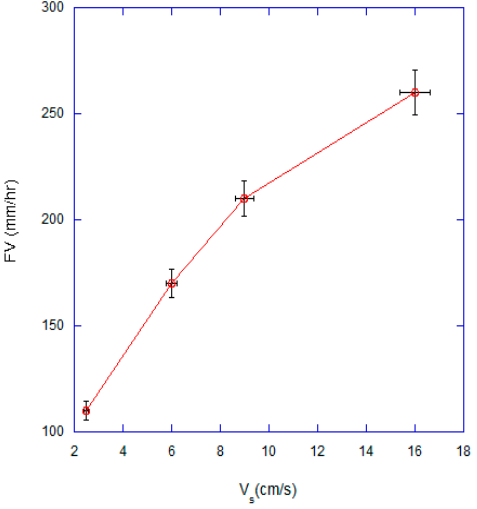
Figure 7. Effect of the superficial velocity on the pyrolysis front velocity.